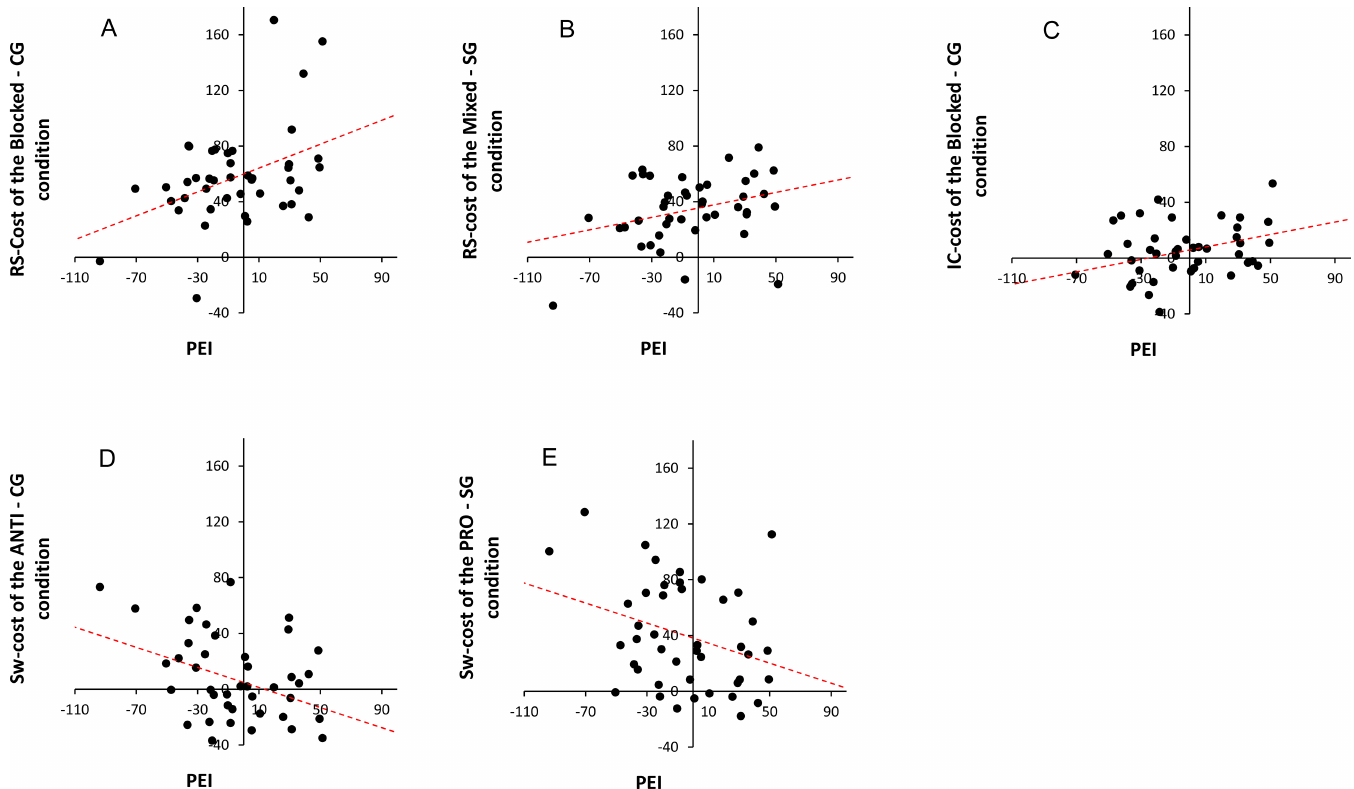
Fig 6. Significant correlations. Correlation results betweenprimingeffects in the ignoredcondition(in abscissa) and performances (in ordinate)for: (A) the changed-gazeblocked-Suppression-cost; ( B) the straight-gaze mixed-Suppression-cost; ( C) the changed-gaze blocked-Inhibition-cost; ( D) the changed- gaze ANTI-Switching-Cost; (E) the